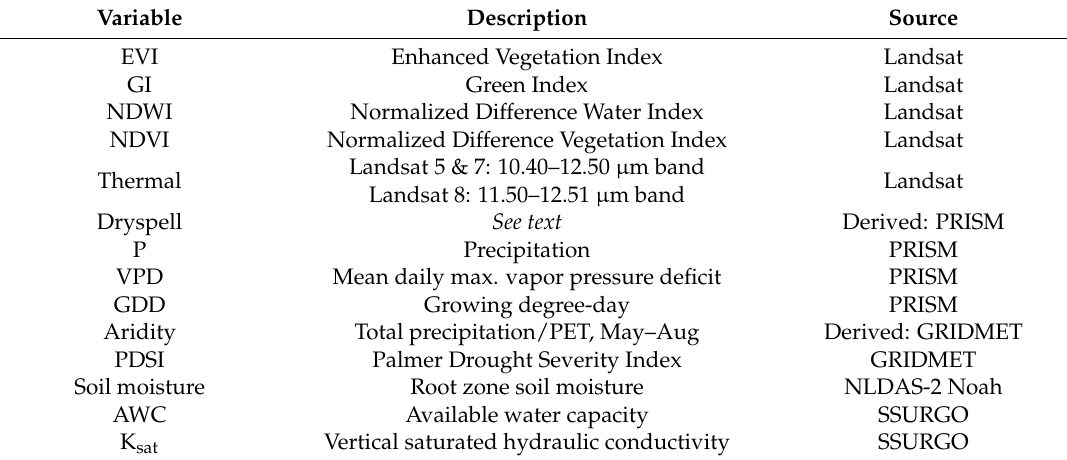
Table 1. Basic input variables and indices used to calculate derived input variables.